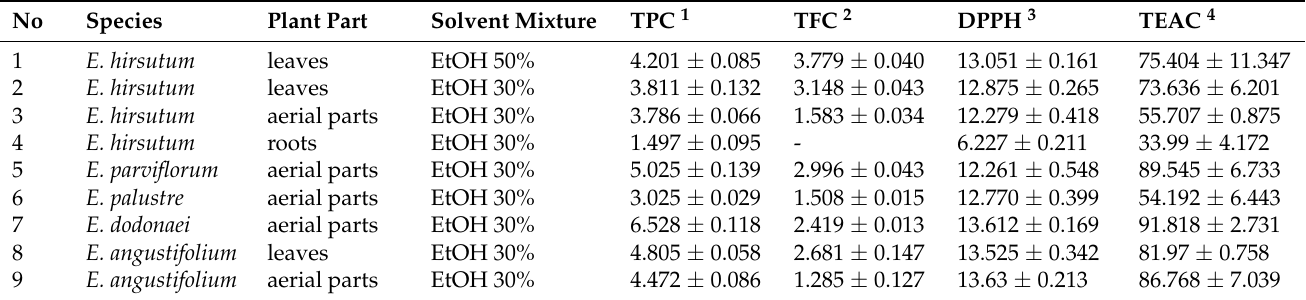
Table 5. Determination of TPC, TFC, and antioxidant activity through DPPH and TEAC assays for the optimized Epilobium sp. extracts (mean value ± SD, n =